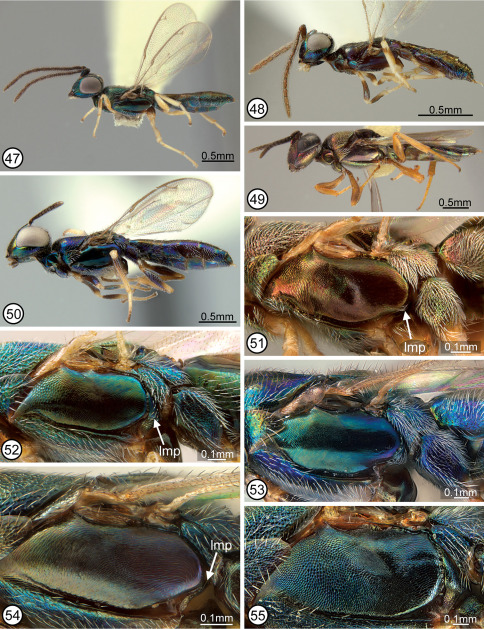
47−50 lateral ♂ habitus (allotype): 47 Calosota setosa 48 Calosota albipalpus 49 Calosota bicolorata 50 Calosota speculifrons 51−55 lateral ♀ mesosoma/acropleuron 51 Calosota setosa (1) 52 Calosota acron (50) 53 Calosota speculifrons (holotype) 54 Calosota vernalis (43) 55 Calosota aestivalis (44). Numbers in parentheses = CNC Photo 2009-no. Abbreviation: lmp = lower mesepimeron.